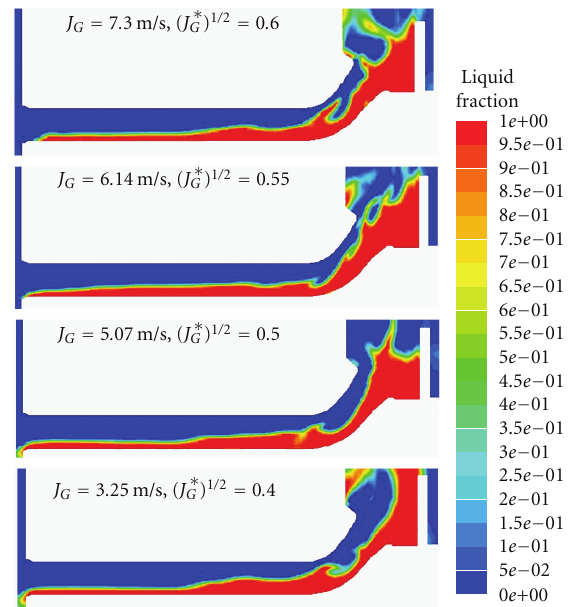
Figure 8: Flow patterns for the 1/5-scale tests (laminar